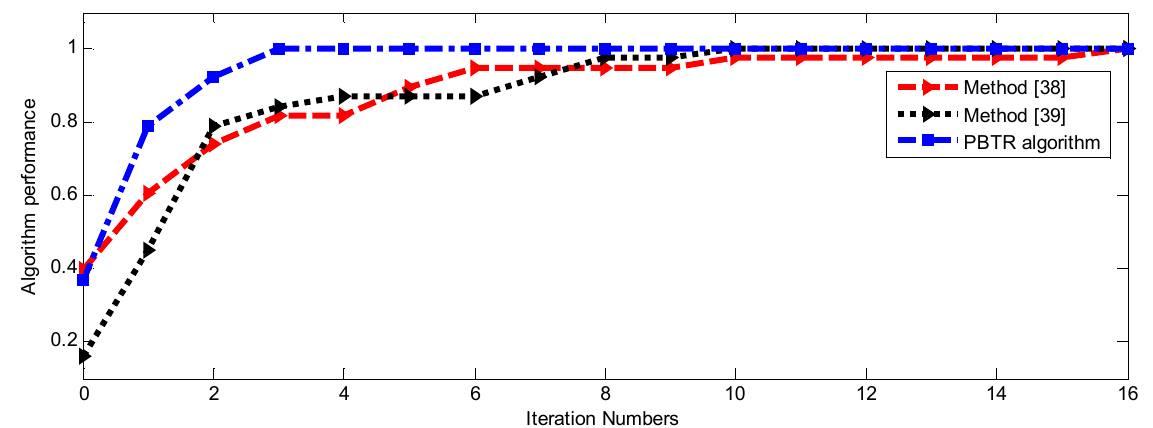
Figure 3. Performance profile based on Niter of methods in [38,39] and the PBTR algorithm.